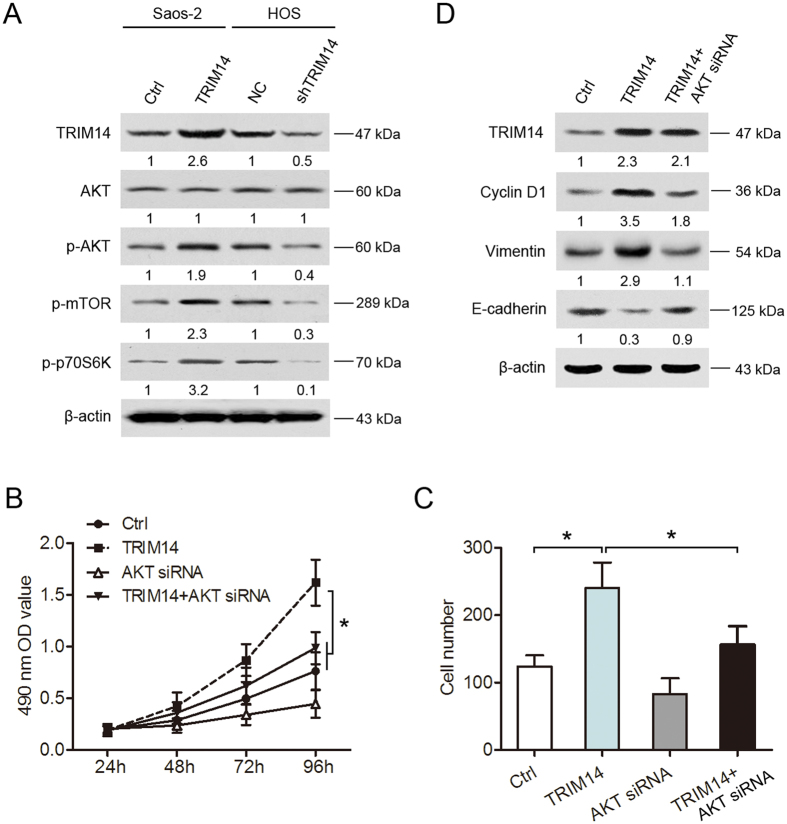
TRIM14 regulates osteosarcoma cell growth and invasion via activating the AKT signaling pathway.(A) Western blot analysis of the indicated proteins in cells. (B) Saos-2/TRIM14 cells were treated with or without AKT siRNA, for 48 h, and cell proliferation and invasion abilities determined with the MTT and Transwell invasion assays, respectively (C). (D) Western blot analysis of the indicated proteins after treatment with AKT siRNA. siRNA, small interfering RNA. *P < 0.05.